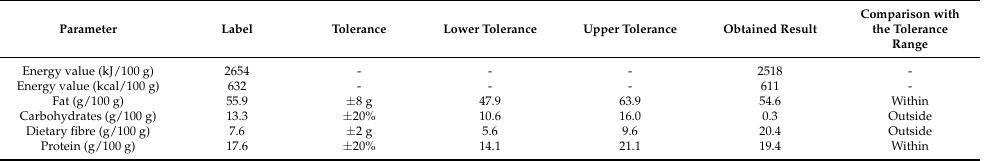
Table 4. Sesame seeds label compliance according to the guidance document for competent author- ities for the control of compliance with EU legislation on Regulation (EU) No. 1169/2011 of the European Parliament and of the Council of 25 October 2011 on the provision of food information to consumers.